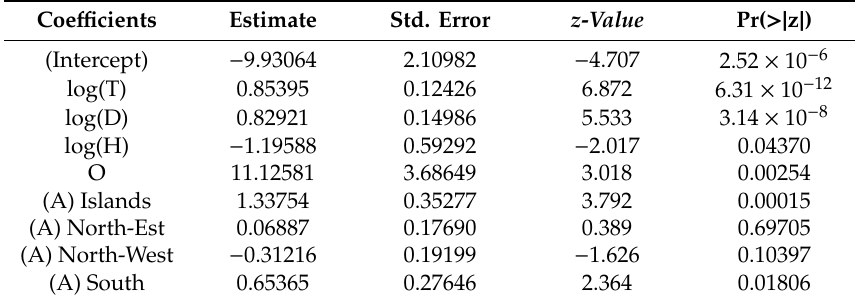
Table 2. Coe ffi cient Estimates for our generalized linear model (GLM). They show how tourism (T) and density (D) are highly significant, as well as the geographical indication (A) for Island and Southern regions (albeit less). The percentage of elderly (O) is also included. Coe ffi cients Estimate Std. Error z - Value Pr( >| z |